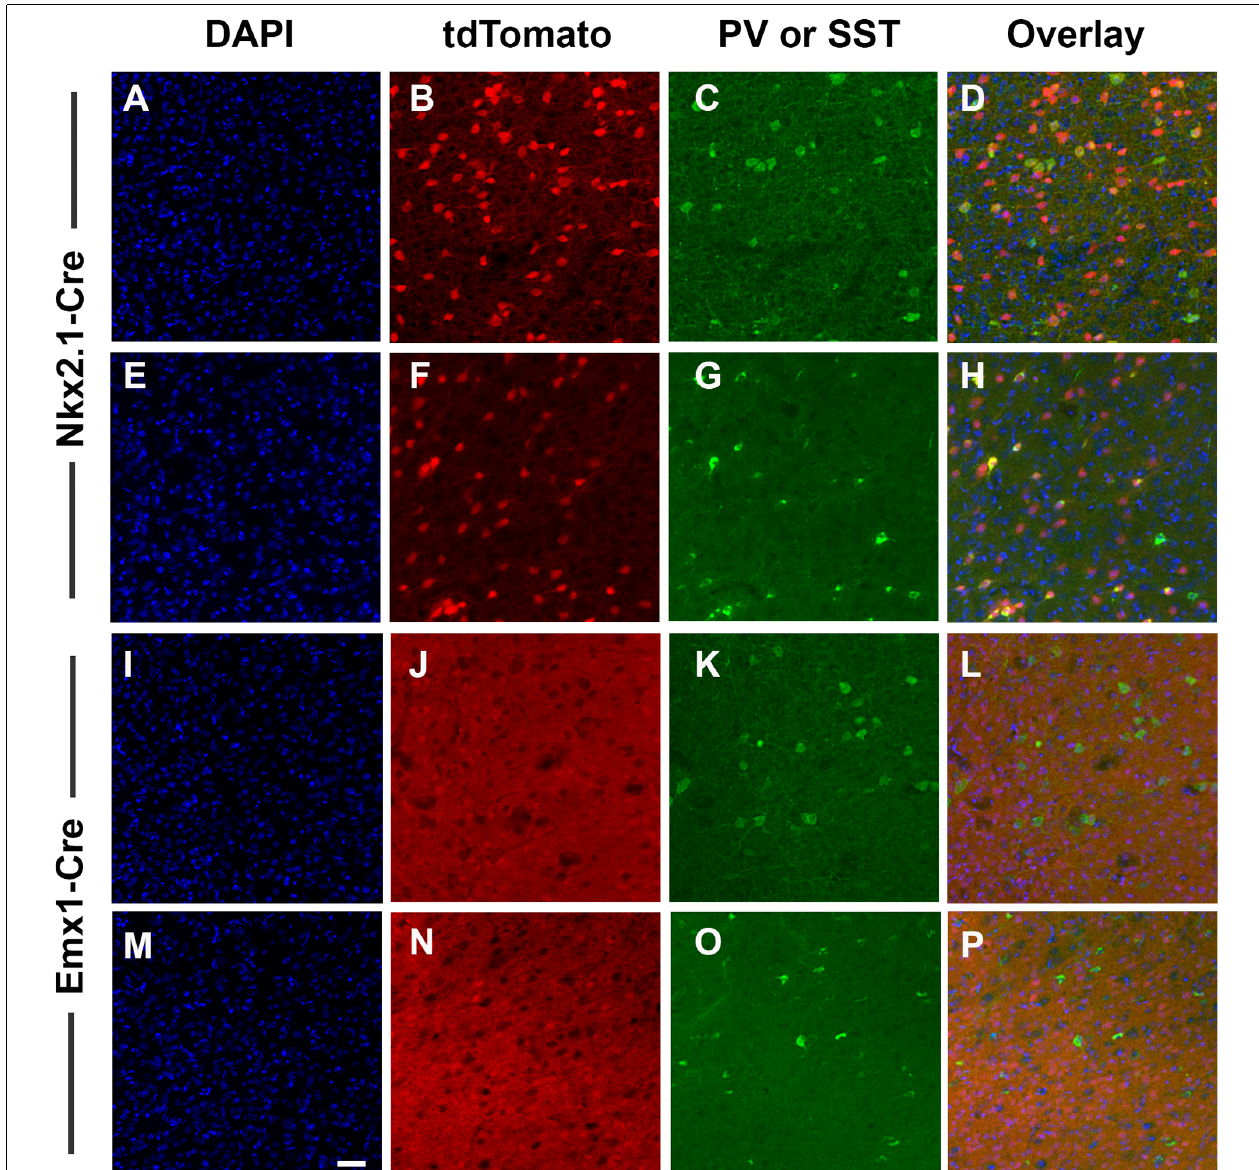
FIGURE 1 | Validation of cell-type specificity of recombination. Nkx2.1 -Cre and Emx1 -Cre mice were bred to the B6.Cg-Gt(ROSA)26Sortm14(CAG-tdTomato)Hze line as an initial validation test. Offspring express bright tdTomato fluorescence throughout each cell where Cre-mediated recombination has occurred (red). Images were collected with a 20 × objective and scale bar = 50 µ m. The result of Nkx2.1 -induced recombination in the anterior cingulate cortex (ACC) is shown in panels (A–H) , and following Emx1 -Cre-induced recombination in panels (I–P) . Sections were also processed for DAPI (blue) and for immunostaining against PV (green C,K ), or SST (green, G,O ). Nkx2.1 -Cre-induced recombination was present in scattered cells throughout the ACC (B,F) , and included interneurons immunoreactive for PV (C) and SST (G) . In contrast, Emx1 -Cre-induced recombination was present in a dense array of cells and processes throughout the ACC (J,N) , but interneurons immunoreactive for PV (K) and SST (O) were largely absent of tdTomato, consistent with the identity of Emx1 -Cre-derived recombined cells being glutamatergic pyramidal cells rather than GABAergic interneurons. Images displayed are representative of N =